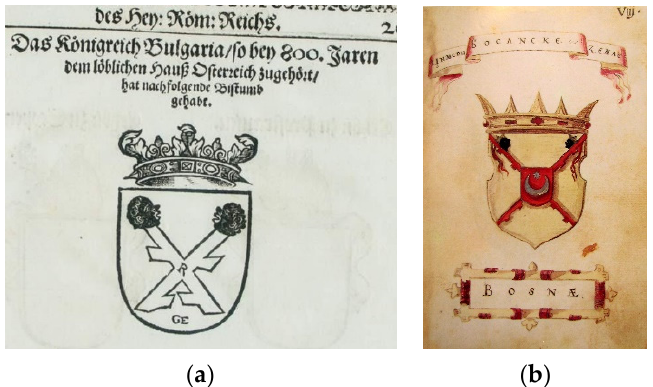
Figure 11. ( a ) CoA of Bulgaria from Schrot’s Wappenbuch 1580. ( b ) CoA of Bosnian from Korenich- Neorich armorial.